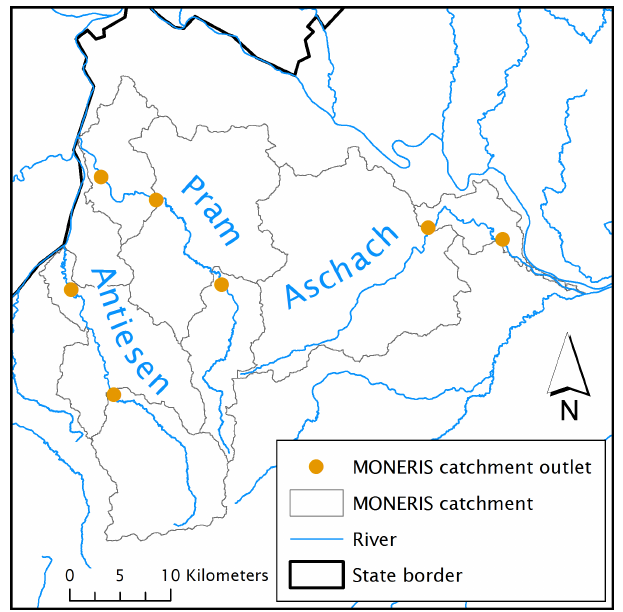
Figure 6. MONERIS (Modelling of Nutrient Emissions in River Systems) sub-catchment outlets for the rivers Pram, Aschach and